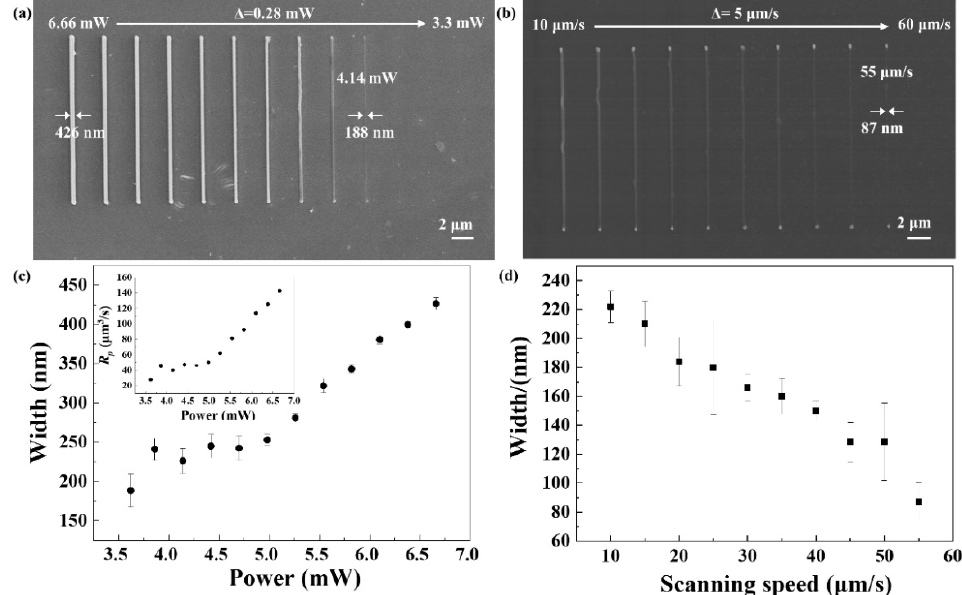
Figure 2. ( a ) SEM image of nanolines achieved with laser power ranging from 6.66 to 3.3 mW at 10 μ m/s. ( b ) SEM image of nanolines achieved with scanning speed ranging from 10 to 60 μ m/s at 6.40 mW. ( c ) The dependence of line width and polymerization rate (inset) on laser power, respectively. ( d ) The dependence of line width on scanning speed.